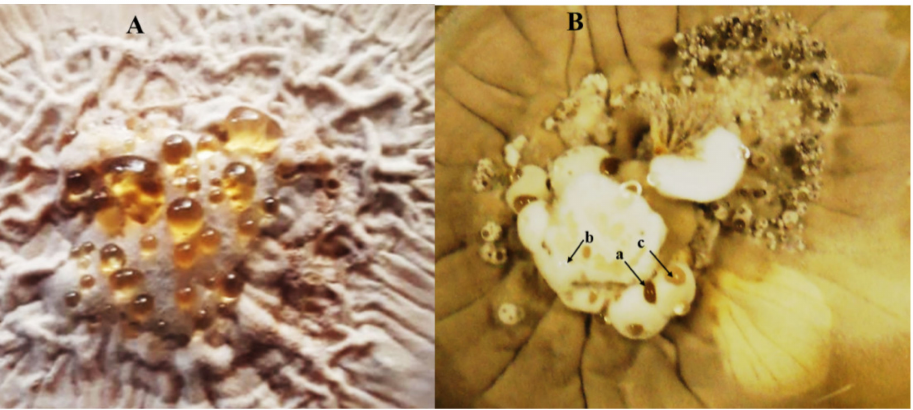
Figure 4. Different exudates produced by Mexican Hirsutella citriformis strains grown on potato dextrose agar supplemented with 0.1% yeast extract (PDAY). ( A ) H. citriformis strain producing mostly light brown exudates and ( B ) H. citriformis strain producing (a) deep brown, (b) crystalline, and (c) light brown exudates.